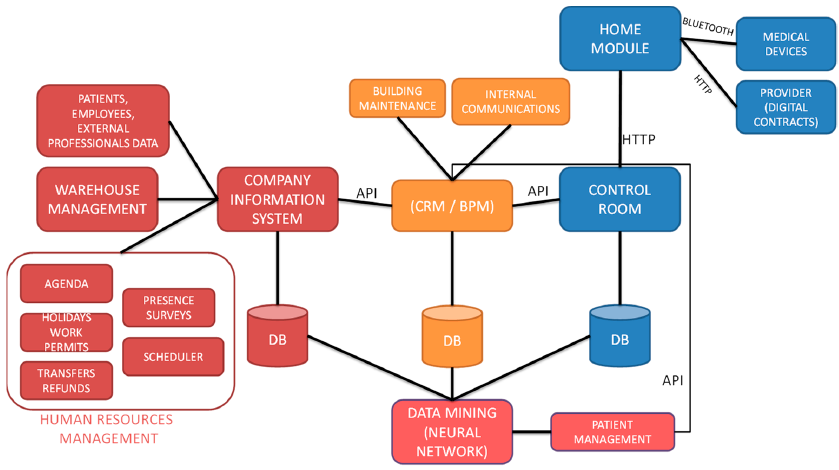
Figure 3. Information workflow of the information system associated with the architecture of Figure 1.